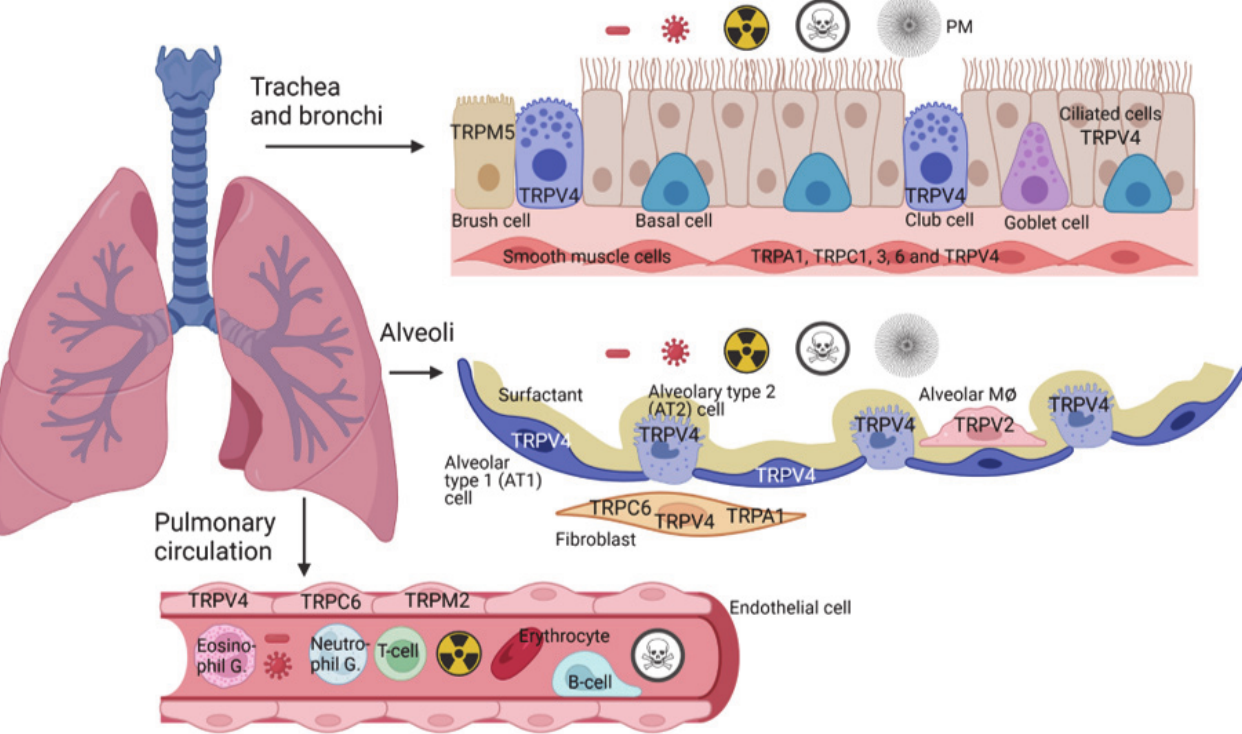
Figure 1. Cells of the human and murine respiratory tract and TRP channel function. The upper part of the lower airways with basal, goblet, club and ciliated cells as well as the alveolus and the pulmonary vasculature are shown. Functional active TRP channels based on reported data are indicated. In the very specialized brush cells TRPM5 channels are exclusively active. In the alveoli, alveolar type 1 (AT1) cells are important for barrier function, while AT2 cells secrete a surfactant that can renew damaged AT1 cells. Alveolar and interstitial macrophages (MØ) are able to phagocytize microorganisms and particulate matter (PM). Fibroblasts involved in wound healing own TRPC6 and TRPA1 proteins. The latter channel, however, exists only in human and not in mouse fibroblasts. Endothelial cells as natural barrier to exclude toxicants perfused in the blood need active TRPC6, TRPM2 and TRPV4 channels. PM, particulate matter. See also Table 1 for single-cell mRNA expression data and the text for more